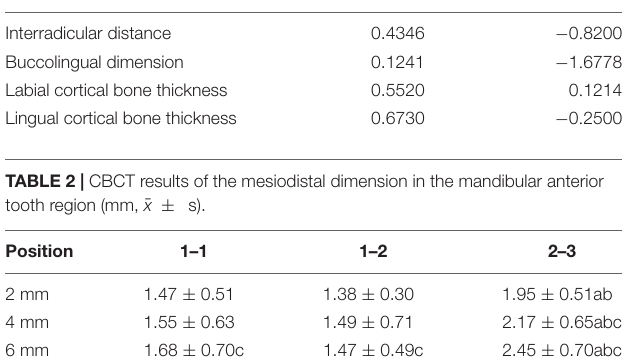
time, and ability to meet the requirements of absolute anchoring.